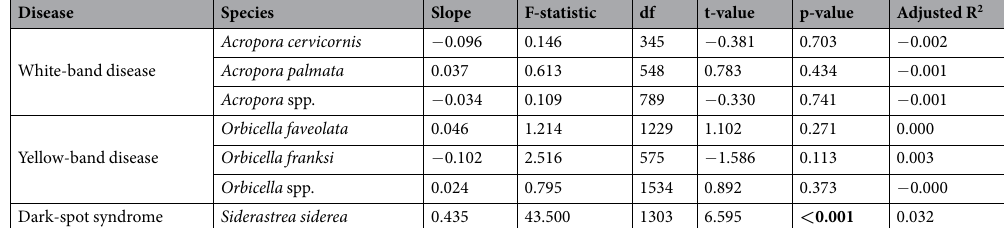
Table 1. Results of regression models evaluating long-term trends in the average annual prevalence (%) of three coral diseases in the Caribbean from 1997–2014. df denotes degrees of freedom.